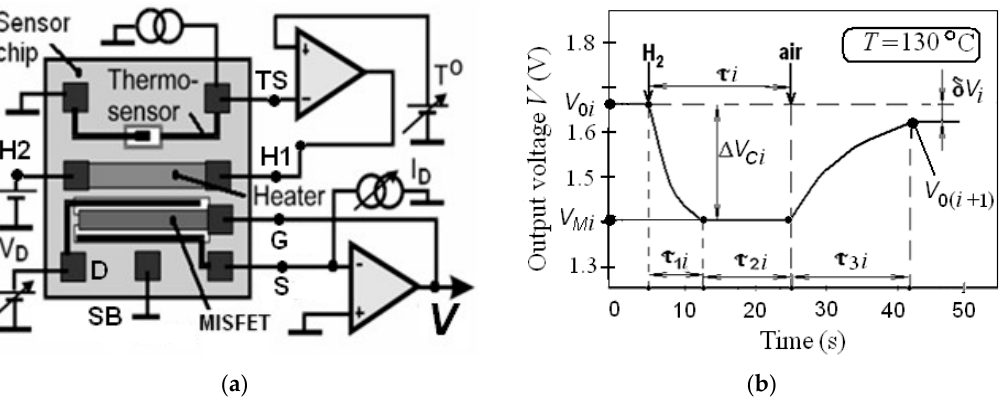
Figure 3. ( a )The simplified structure of the sensor characteristic measuring circuitry; ( b ) The typical i- hydrogen response and its parameters at C i being equal to 0.05% vol. Table 1. Average values of the parameters of MISFETs and the used parameter models (3). Symbols